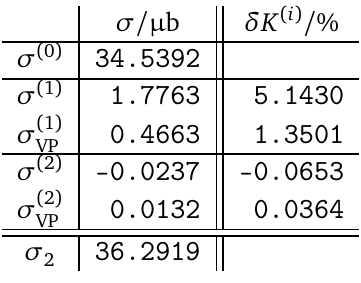
Table 3: Results for the integrated cross section for the P2 setting at LO, NLO, and